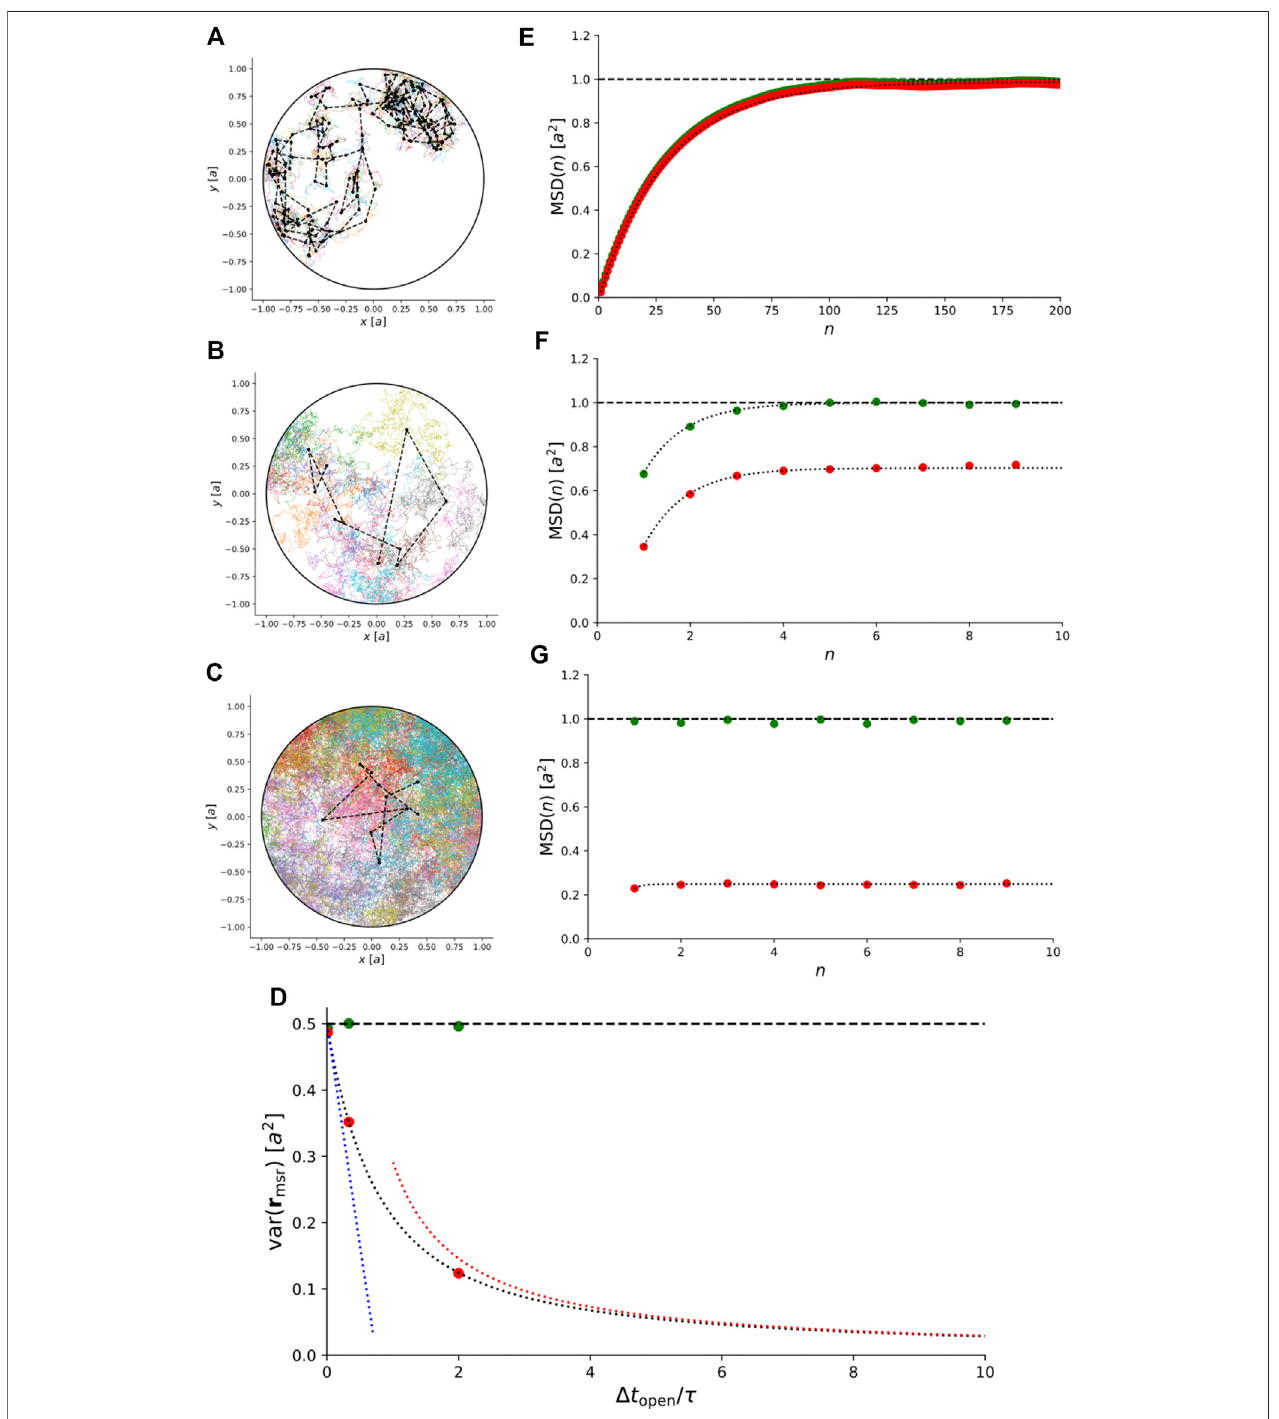
FIGURE4| Simulationsof2DBrownianmotioncon fi nedtoacirculardomainwithradius a . (A) – (C) Simulated trajectoriesfor Δ t / τ (cid:2) 0.01,0.33,and2,respectively, and Δ t (cid:2) Δ t open .Themeasured positions,whichareaffectedbymotionblur,areindicatedwithblackdotsconnectedbydashed lines.Theunderlyingpositionsvisitedby theparticleduringeachframeinthetime-lapsemovieareshownwithdifferentcolorforeachframe,plottedontopofeachotherwiththelatestframeontop. (D) Variance forthesamevaluesoftheratio Δ t / τ asinpanels (A) – (C) (reddots).Dottedcurves:theexactresultforthevariancein Eq.28 (black),theapproximateresultin Eq.29 valid for Δ t open ≪ τ (blue), and the approximate result in Eq. 30 valid for Δ t open ≫ τ (red). Horizontal black dashed line: variance (cid:2) a 2 / 2, the value for Δ t open / τ → 0. (E) – (G) Mean-squared displacements (MSDs) for Δ t / τ (cid:2) 0.01, 0.33, and 2, respectively, and with Δ t (cid:2) Δ t open . Colored dots: measured positions excluding (green) and including (red) the effect of motion blur. Dotted lines through colored dots: exact results excluding ( Eq. 32 ) and including ( Eq. 31 ) the effect of motion blur. The horizontal black dashed line marks a 2 , the limit reached for Δ t / τ → 0 and n → ∞ .